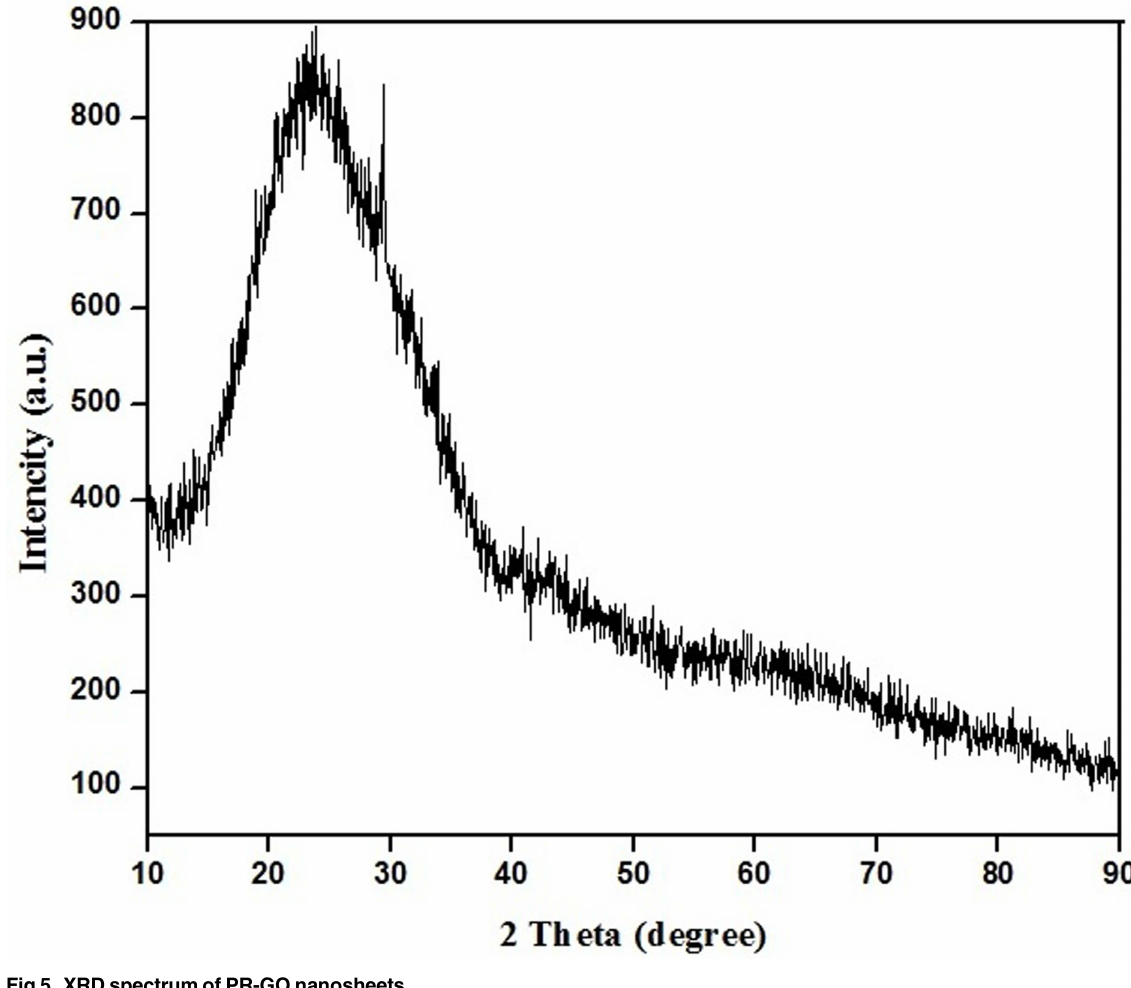
Fig 5. XRD spectrum of PR-GO